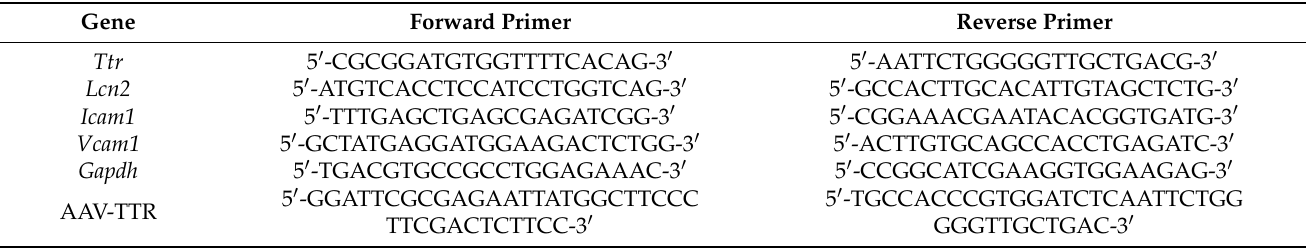
Table 1. Primers for RT-qPCR and oligonucleotides for